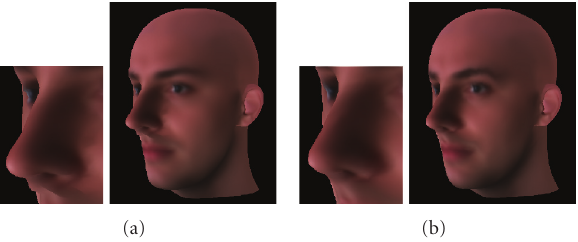
Figure 8: Synthesis of the nose shape: (a) Without shape blending, the obvious geometric discontinuities around the boundary of the nose region impair realism of the synthesis to a large extent. (b) Using our approach, the geometries of the feature region and surrounding areas are smoothly blended around their boundary.